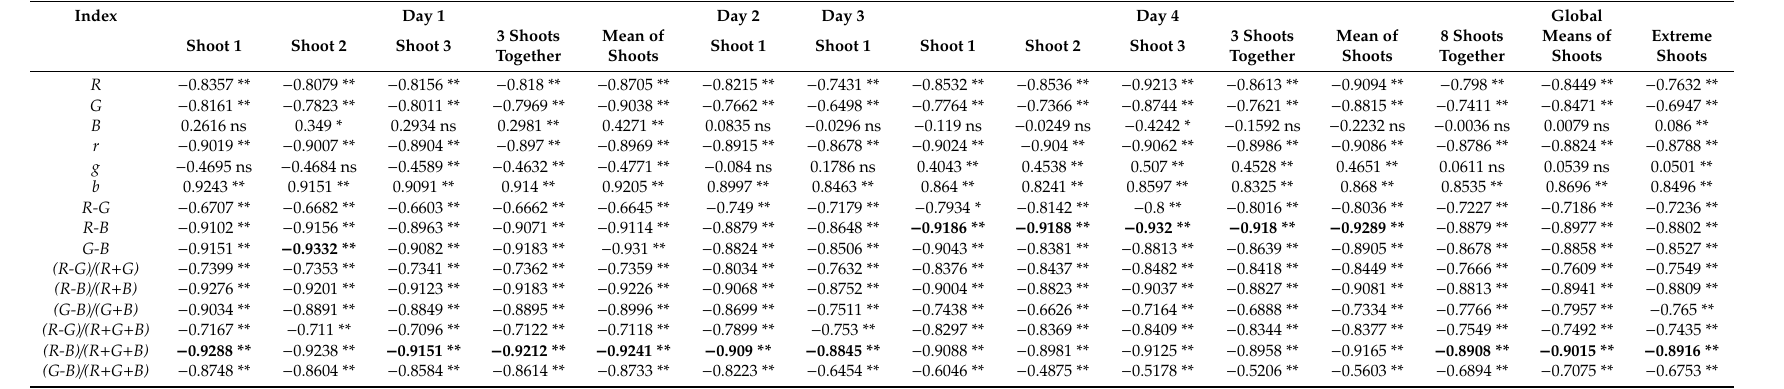
Table 3. Correlation coe ffi cients for indices studied by Kawashima et al. [32]. Results are given for each individual shoot, for daily values on days #1 and #4 (taking into account the three shoots altogether or the mean values of the three shoots) and for global datasets. The latter include data from all the days using the eight shoots, data from all the days using mean values for days #1 and #4 and mean values between extreme shoots (the darkest shoot from day #1 and the brightest shoot from day #4). The highest R-values are highlighted in bold typeface. Significance levels: ** ( p < 0.01) and * ( p <